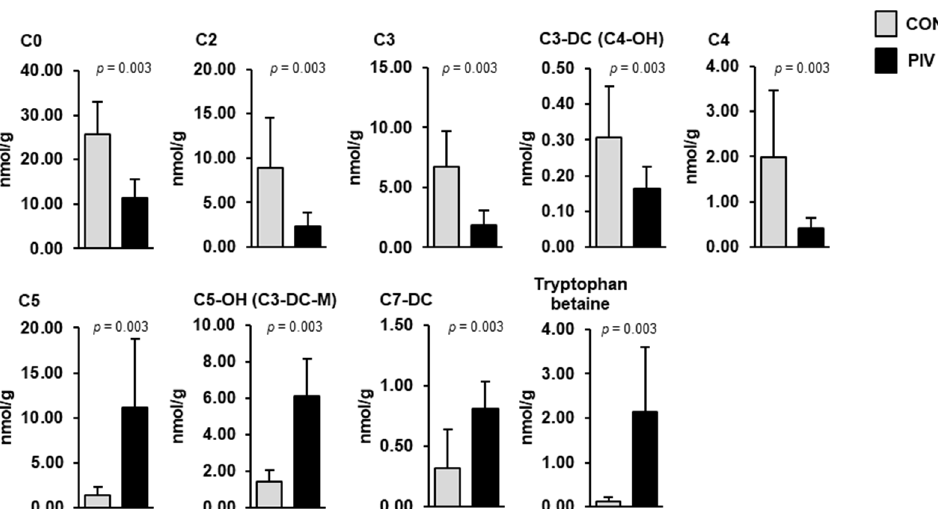
Figure 4. Concentrations of liver metabolites regulated between 5-week-old pigs orally administered either vehicle (group tered either vehicle (group CON) or pivalate (group PIV) for 28 days as identified by targeted CON) or pivalate (group PIV) for 28 days as identified by targeted plasma metabolomics. Bars are means ± SD for n = 6 plasma metabolomics. Bars are means ± SD for n = 6 pigs/group. Abbreviations: C, pigs/group. Abbreviations: C, carnitine; C0, free carnitine; C2, acetylcarnitine; C3, propionylcarnitine; C3-DC (C4-OH), malonylcarnitine (3-hydroxybutyrylcarnitine); C4, butyrylcarnitine; C5, isovalerylcarnitine, valerylcarnitine, 2- methylbutyrylcarnitine and/or pivaloylcarnitine; C5-OH (C3-DC-M), hydroxyvalerylcarnitine (methylmalonylcarnitine); C7-DC, pimelylcarnitine.